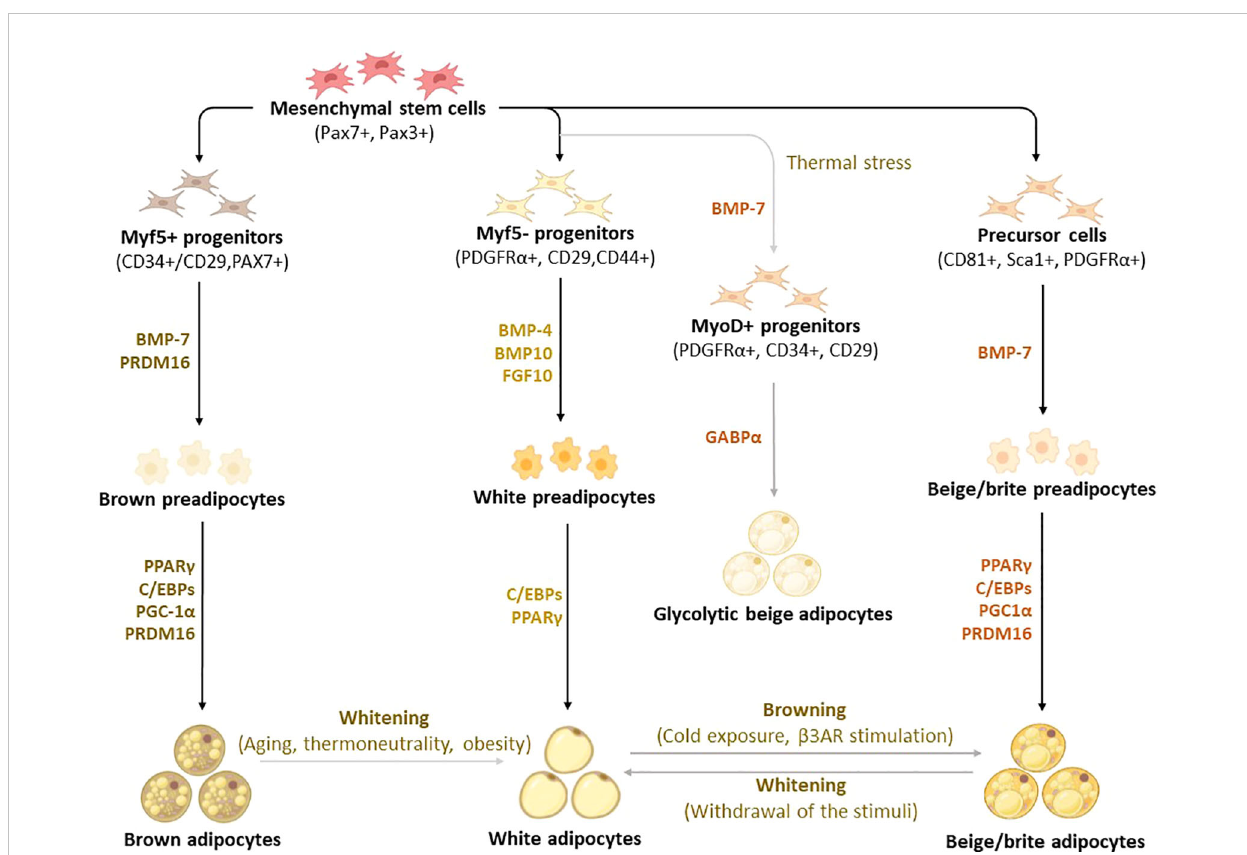
FIGURE 2 Differentiation and transdifferentiation trajectories of major adipocyte populations, including brown and white adipocytes, as well as canonical and glycolytic beige/brite adipocytes. Generally, brown adipocytes are derived from Myf5+ progenitors, whereas white and beige adipocytes originate from Myf5- progenitors that descend from mesenchymal stem cells. New advances on adipocyte origin show that there is another subpopulation of beige adipocytes known as glycolytic beige adipocytes, which are derived from MyoD+ progenitors within the stromal vascular fraction of inguinal WAT in response to thermal stress. During differentiation secretory factors BMP-7 and transcriptional factor PRDM16 induce Myf5+ cell commitment to brown preadipocytes whereas BMP-4, BMP-10, and FGF10 induce Myf5- cell commitment to white preadipocytes. On the other hand, BMP-7 induces a commitment of beige adipocyte precursors to canonical beige preadipocytes. Differentiation of all types of preadipocytes into mature adipocytes is driven by PPAR g , and C/EBPs, whereas brown and beige adipocytes require the expression of additional factors, including PRDM16 and PGC1 a . Moreover, GABP a regulates the differentiation of glycolytic beige adipocytes. During transdifferentiation, white adipocytes convert to beige adipocytes following cold exposure or b 3-AR stimulation. Likewise, brown and beige adipocytes can transdifferentiate into white-like adipocytes, a process termed whitening. b 3-AR, beta-3 adrenergic receptor; BMP, bone morphogenetic protein; C/EBPs, CCAAT/enhancer-binding proteins; GABP a , GA-binding protein alpha; PGC1 a , peroxisome proliferator-activated receptor coactivator 1 alpha; PPAR g , peroxisome